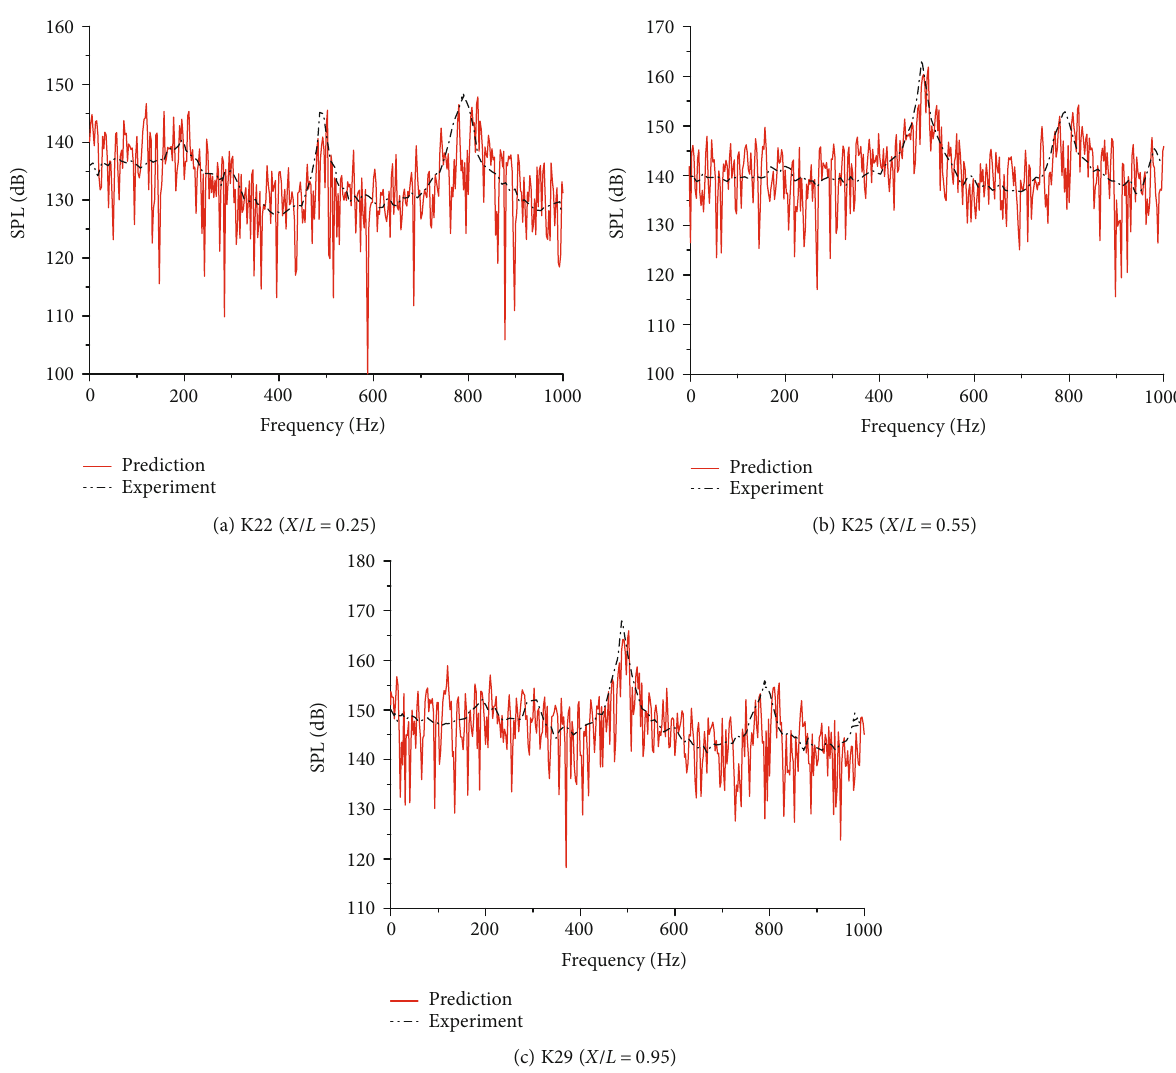
Figure 8: Comparison of spectrum between calculation and test at Ma = 1 : 35 .